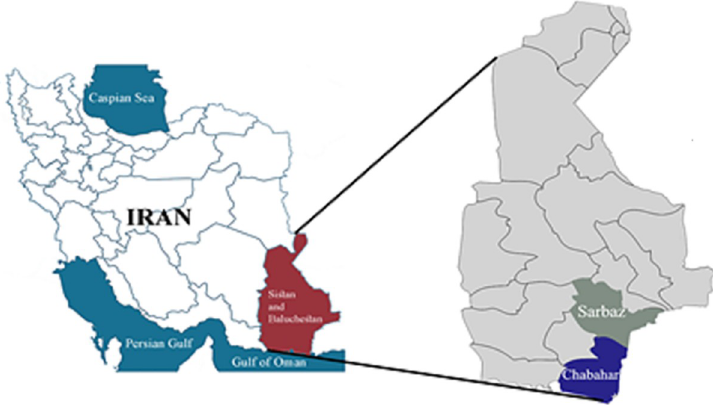
Fig 1. Map of Iran showing the locations in which tick samples were collected (https://commons.wikimedia.org/